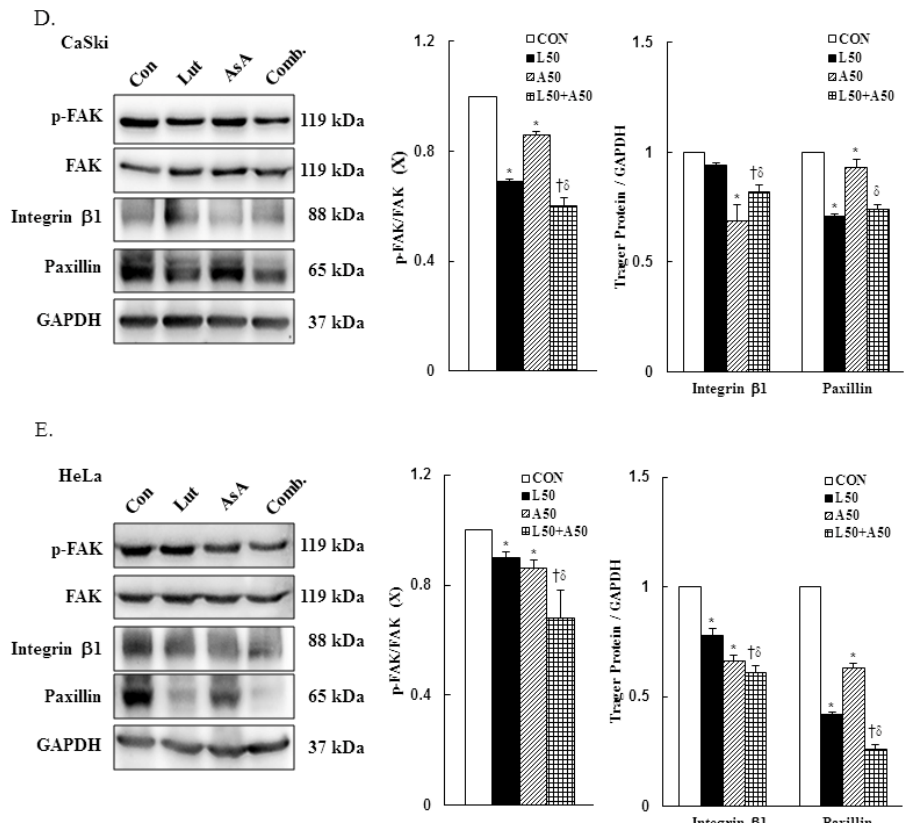
Figure 5. Luteolin combined with asiatic acid inhibited cell migration and inactivated the integrin β 1/FAK/paxillin pathway. CaSki and HeLa cells were treated with Lut (50 µ M) or AsA (50 and 75 µ M) alone or in combination. ( A ) Representative images of scratches and recovery of wounded areas (marked by red lines) on cell monolayers at 0, 12 and 24 h after wounding. CaSki ( B ) and HeLa ( C ) cell semi-quantitative analysis of relative wound closure was performed by measuring the width of the wounds. Cell migration-related proteins, p-FAK, integrin β 1 and paxillin, levels in CaSki ( D ) and HeLa ( E ) cells were analyzed through western blotting after 24 h of treatment. GAPDH served as the loading control. Quantitative results are shown in the lower plot. Values represent mean ± SD from three replicates. *, †, δ and γ p < 0.05 compared with CON, L50-, A50- or A75-treated group. CON, 0.1% DMSO; L50, 50 μ M luteolin; A50, 50 μ M asiatic acid; A75, 75 μ M asiatic acid. L50 + A50,